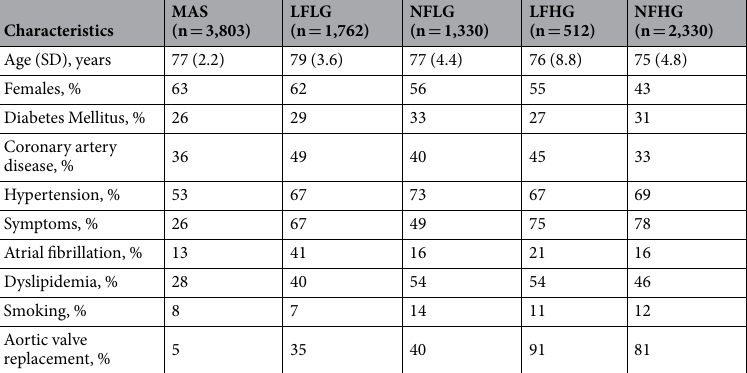
Table 2. Baseline Characteristics Stratified by Flow-Gradient